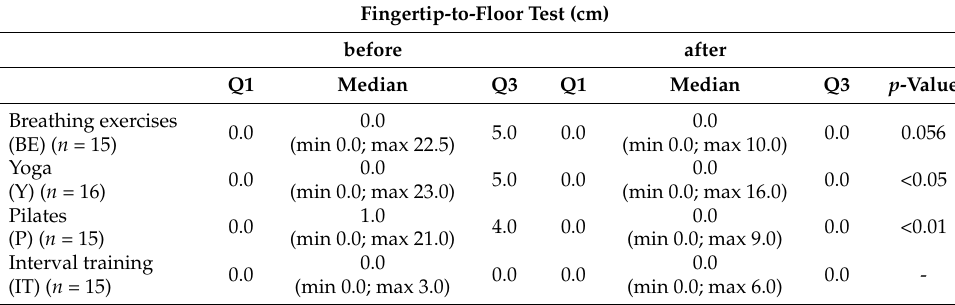
Table 5. Results of the fingertip-to-floor test (cm) of the four groups (target BE programme and three other programmes: yoga, Pilates and dynamic interval training) before and after the training